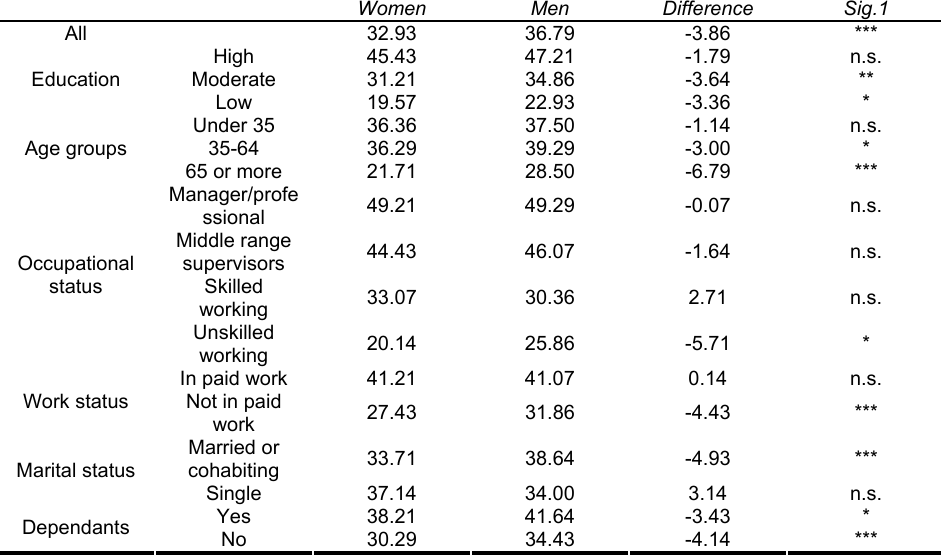
Table 3. Mean of accessibility according to gender and control